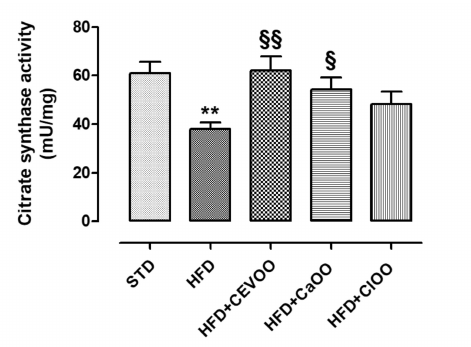
Figure 5. Activity of the enzyme citrate synthase in the adipose tissue. * indicates a statistically significant di ff erence between the HFD group and the STD group. § indicates a statistically significant di ff erence between HFD and HFD + CEVOO or HFD + Ca OO or HFD + Cl OO. Single symbol corresponds to p < 0.05; double symbol to p < 0.01.